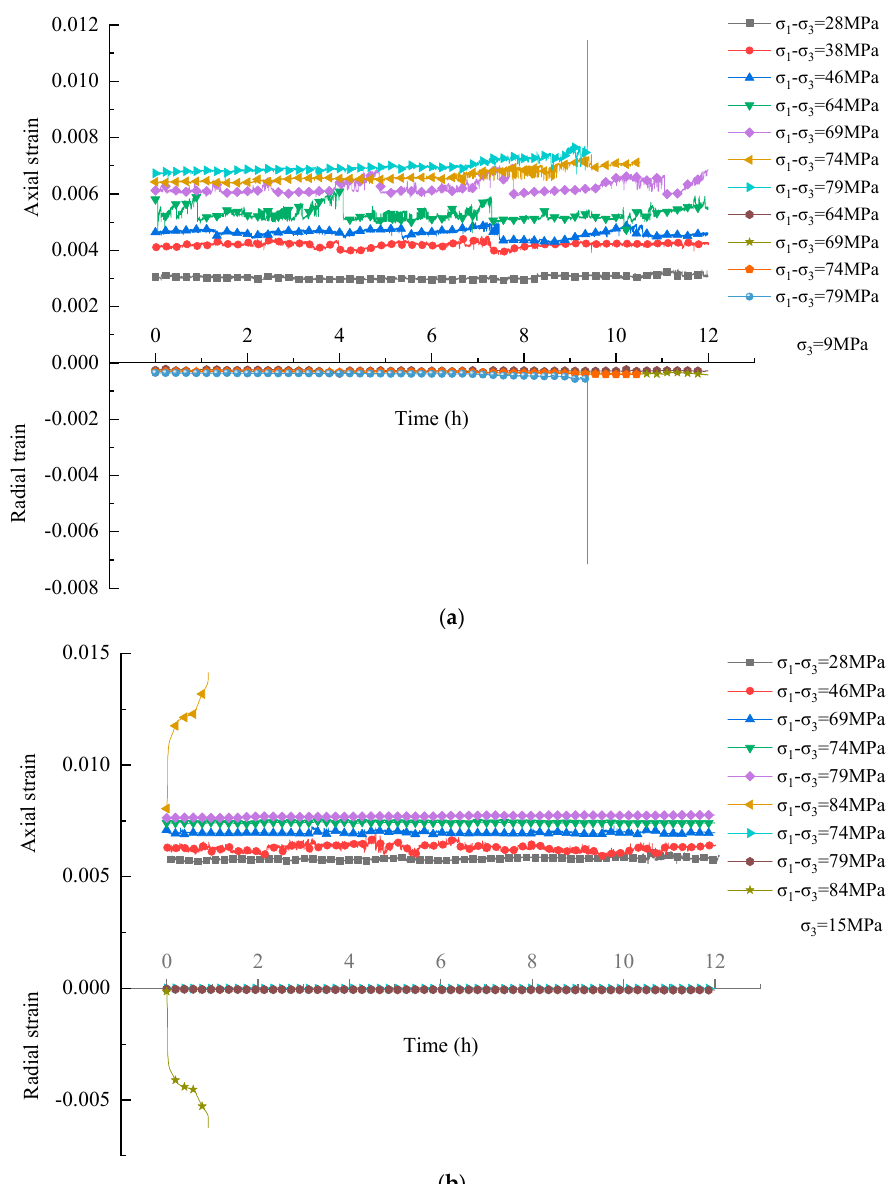
Figure 7. Creep curves of strain–time at confining pressures of ( a ) 9 MPa and ( b ) 15 MPa. Besides, the evolution of volumetric strain versus time at the maximum stress level in the two tests is drawn in Figure 8, because the volumetric strain under other stress levels was generally dominated by compression. Figure 8 shows that during the triaxial compression creep test, the evolution trend of the creep curve of volumetric strain versus time of the sample was basically consistent with that of the curve of radial strain versus time, and had a typical three-stage feature. First, the compression volume strain decreased rapidly, then the compression volume strain decreased slowly. Finally the compression volume strain decreased rapidly and even the expansion volume strain occurred. The variation in volumetric strain is mainly due to the continuous development of damage and cracks in rock samples under high stress resulting in the continuous increase in radial strain; particularly, when the samples were close to complete failure, the lateral expansion deformation was the main